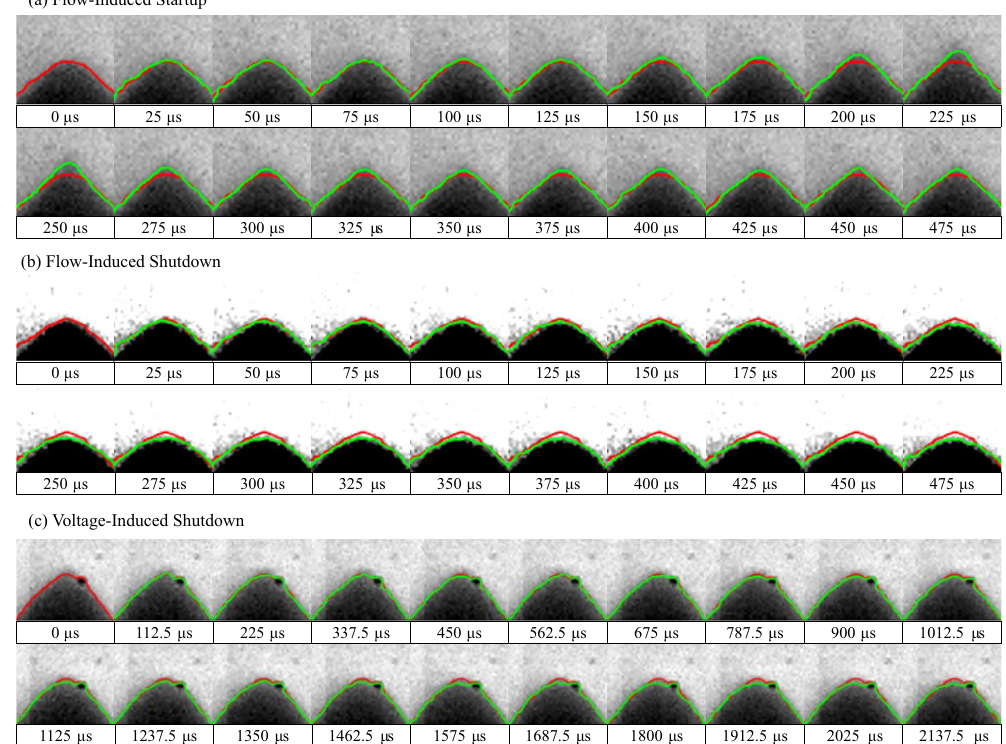
Figure 7. Transient stability test image sequences. The red line represents the initial edge of the meniscus, and is plotted in each subsequent frame as a reference. The green line represents the instantaneous meniscus edge. ( a ) Flow-induced startup, 0pLs − 1 to 1000pLs − 1 , 1.6kV emitter bias. ( b ) Flow-induced shutdown, 1000pLs − 1 to 0pLs − 1 , 1.6kV emitter bias. ( c ) Voltage-induced shutdown, 400pLs − 1 , 1.6kV to 0kV emitter bias. The black mark seen in the series of images near the cone’s contour is an imaging artifact, and not part of the cone. Figure modified from Ref.